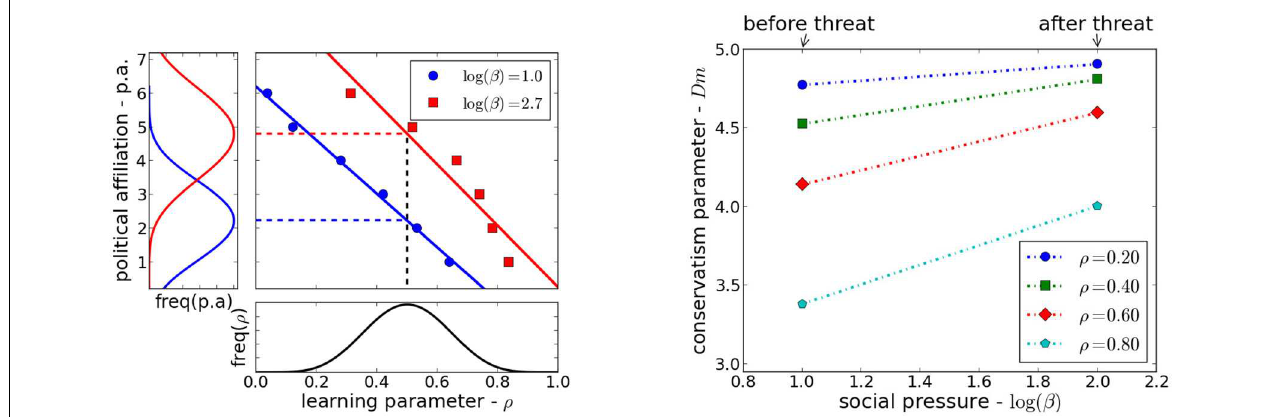
FIGURE 5 | Threats. Left : The level of conservatism changes with pressure. If the population has a distribution of social encounters as shown in the bottom panel, the resulting distributions of political affiliations changes, for different pressures as shown in the left panel.